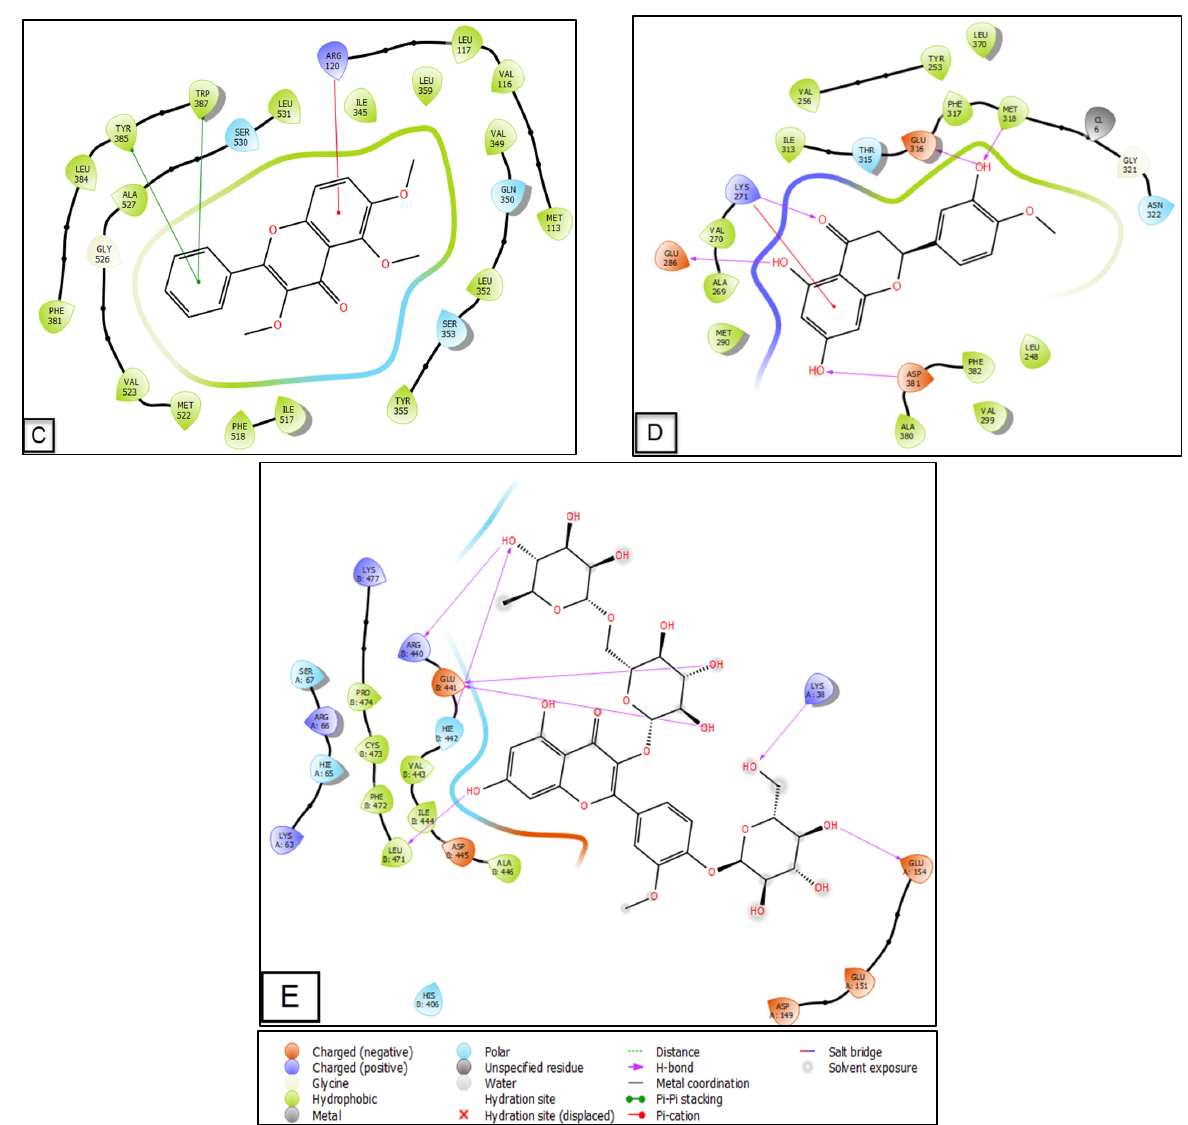
Figure 6. 2D diagrams of candidate ligand interactions with the active sites. ( A ) and ( B ) luteolin 7- O -glucoside interactions with the active site of GSK3- β and CK-1, respectively. ( C ) Trimethoxyflavone interactions with the active site of cyclooxygenase-2. ( D ) Hesperetin interactions with the active site of tyrosine kinase. ( E ) isorhamnetin-3- O -rutinoside interactions with the active site of TRADD.